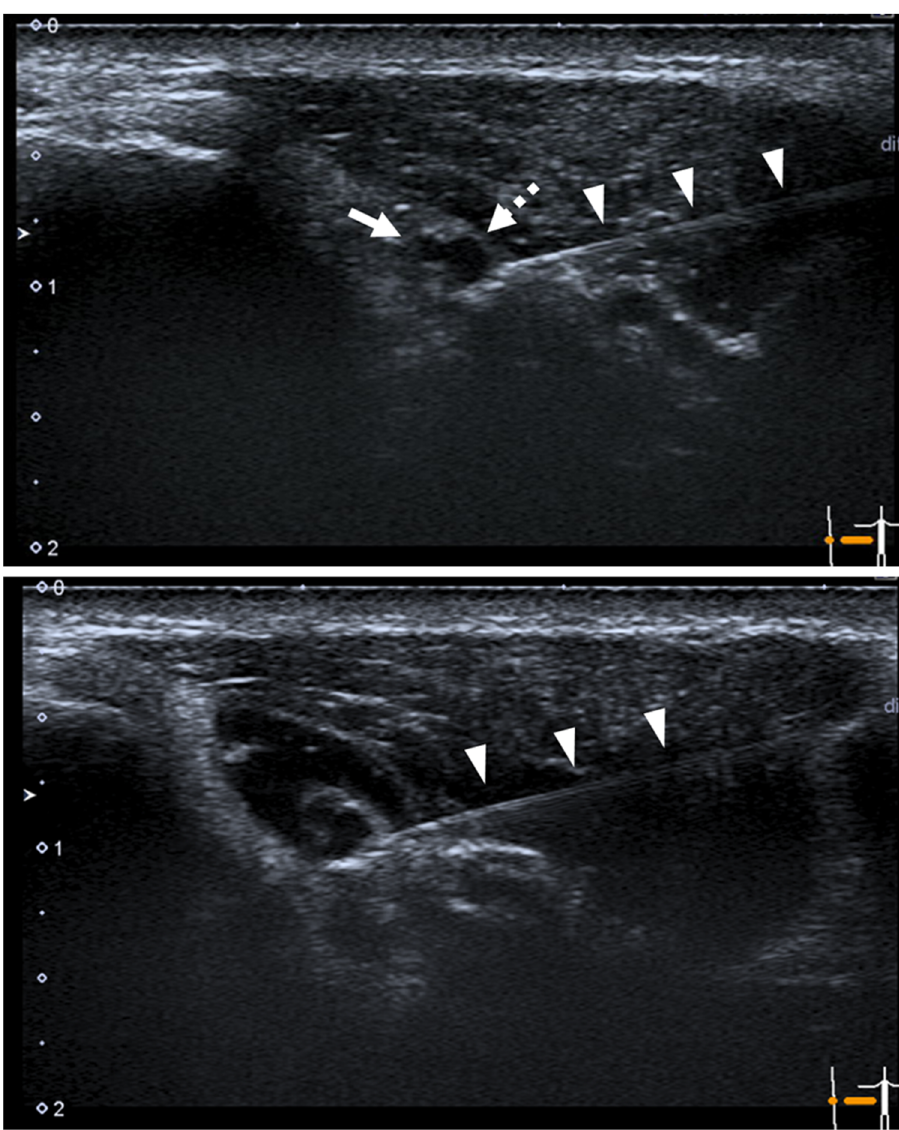
Figure 1. Ultrasound (US) image of US-guided sciatic nerve blocks. Two components of the sciatic nerve, the tibial ( dashed arrow ) and common peroneal nerves ( arrow ), are visualized ( upper panel ). The arrowheads indicate the needle trajectory. The injected anesthetic agent is shown as a low echoic area around the tip of the needle ( lower panel